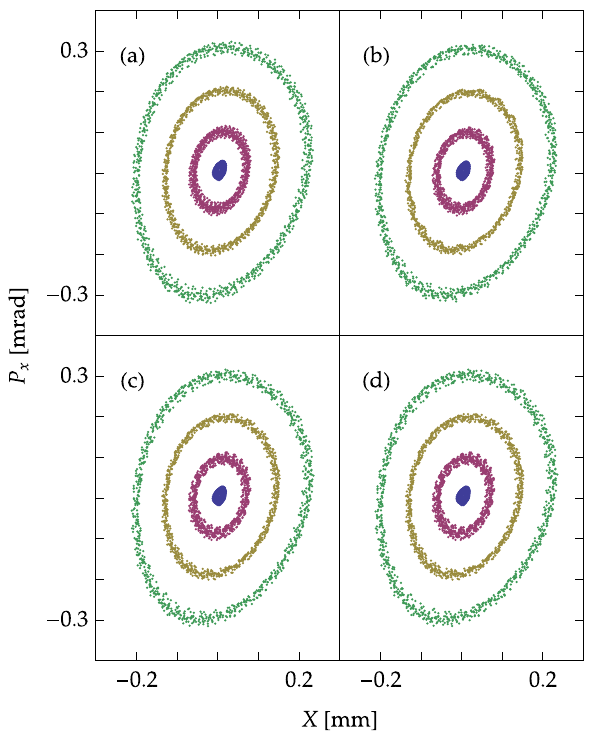
FIG. 3. Spectrum of X obtained using (a) drift-kick integration 4 and (b) n 16 , and using 8 , or (b) BK/MK integration with n with n b ¼ b ¼ b ¼ 1 and (d) n 16 . indicated tunes are all taken modulo b ¼ b ¼